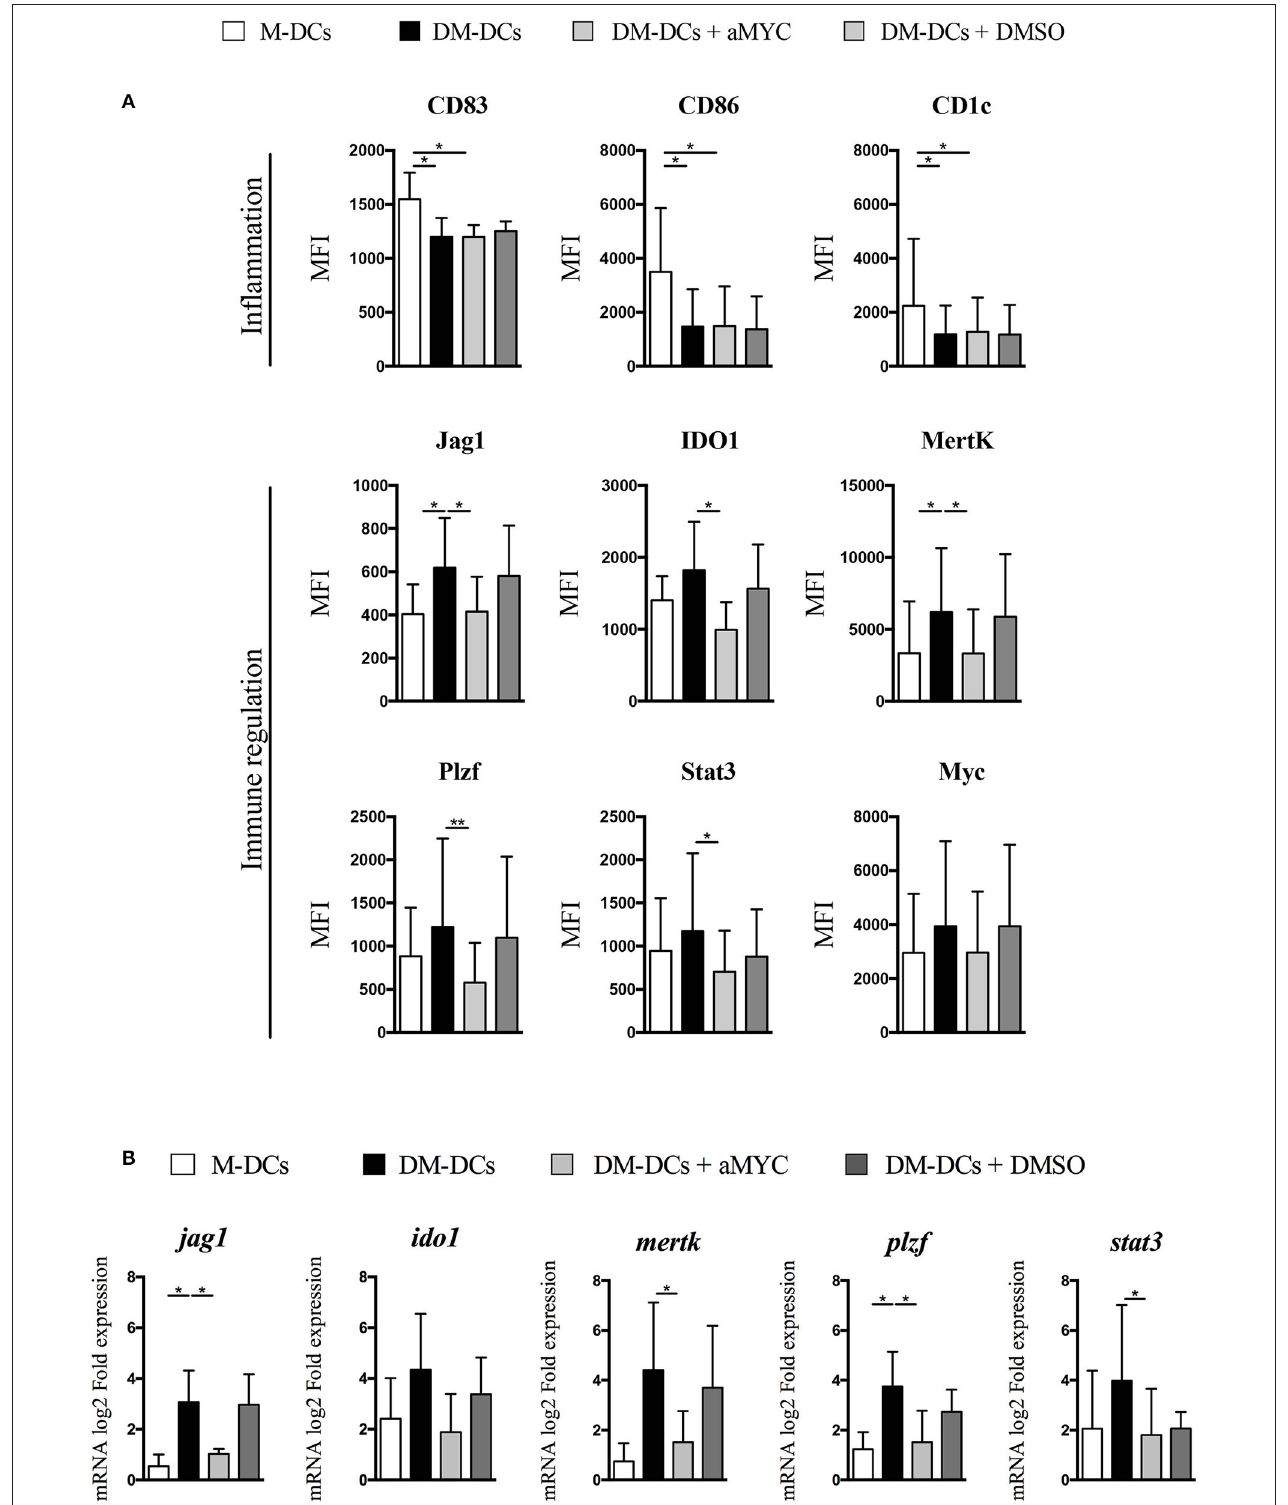
FIGURE 3 | Blockade of MYC leads to inhibition of tolerance-associated gene expression. MYC transactivation of target gene was blocked with the small inhibitor 10058-F4. On day 3 cells were incubated with 10058-F4 (30 µ M) for 48h, after which immune tolerance markers expression was evaluated at the transcriptional